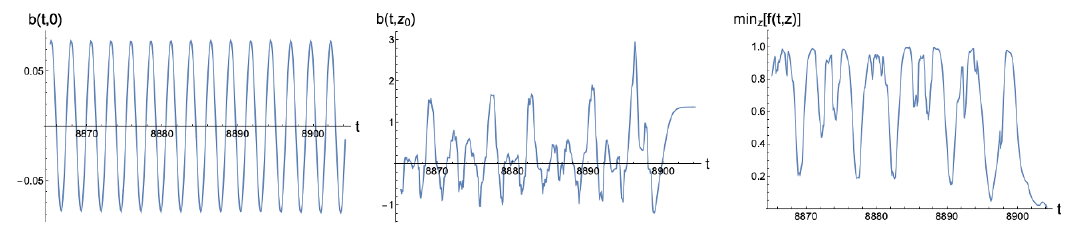
Figure 8 . The same scenario depicted in (cid:12)gure 5, now for the protocol at ! = 2 : 375 of (cid:12)gure 7. The evolution for t> 8000 becomes chaotic, as shown by the time evolution of the b ( t; z 0 ) at the tip.